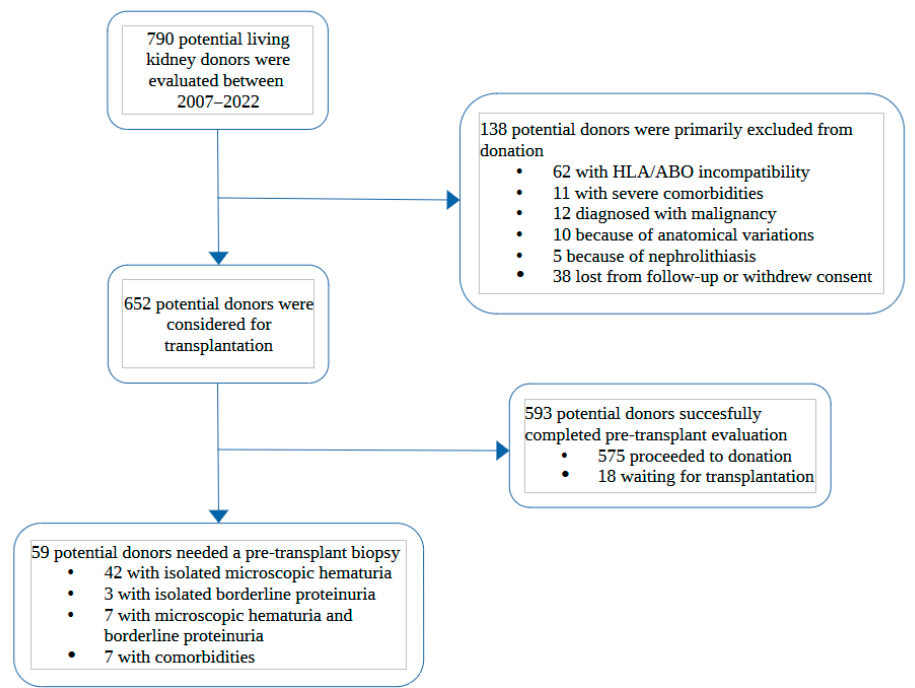
Figure 1. Flowchart describing the kidney donor selection process from initial evaluation in the outpatient clinic to final decision on pre-transplant biopsy. HLA: Human Leucocyte Antigens; comorbidities: long history of hypertension, on ≥ 3 antihypertensive drugs, impaired glucose tolerance or HbA1c, BMI > 30 kg/m 2 .